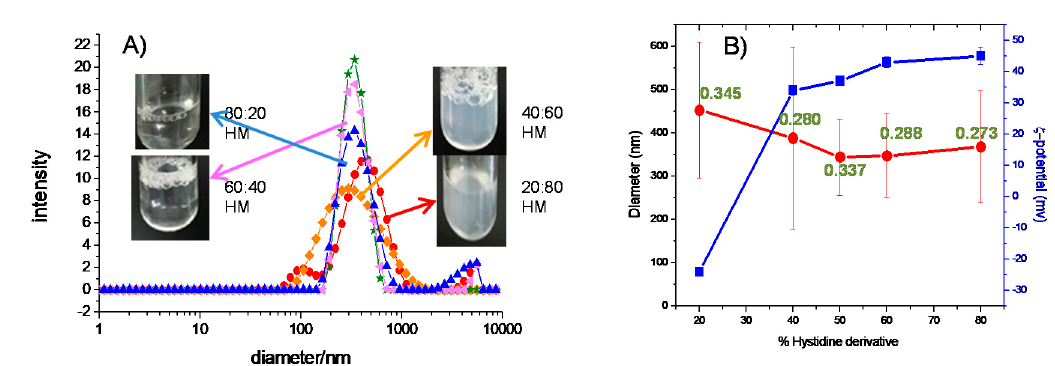
Figure 5. ( A ) Intensity weighed diameter obtained from dynamic light scattering (DLS) and visual appearance of the HM mixtures at 25 °C 80:20 HM, 60:40 HM, 50:50 HM, 40:60 HM, 20:80 HM. ( B ) mean DLS diameter ( left) and ζ -potential results ( right) for the HM formulations.